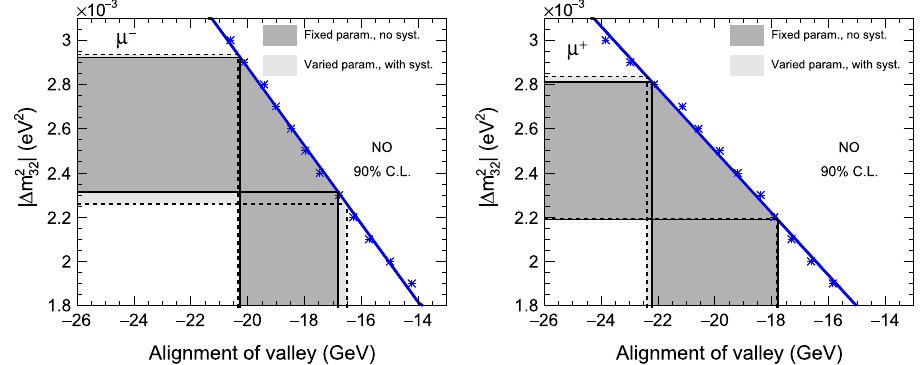
Fig. 10 The blue points and the blue line correspond to the calibra- | with the alignment of the valley, obtained by tion of actual | (cid:3) m 2 32 using the 1000-year MC data sample. The light (dark) gray bands represent the 90% C.L. regions of the alignment of the valley, and | through calibration, with (without) system- hence the inferred | (cid:3) m 2 32 atic uncertainties and error in other oscillation parameters. Here, we | ( true ) = 2 . 46 × 10 − 3 eV 2 and 10-year exposure of ICAL. take | (cid:3) m 2 32